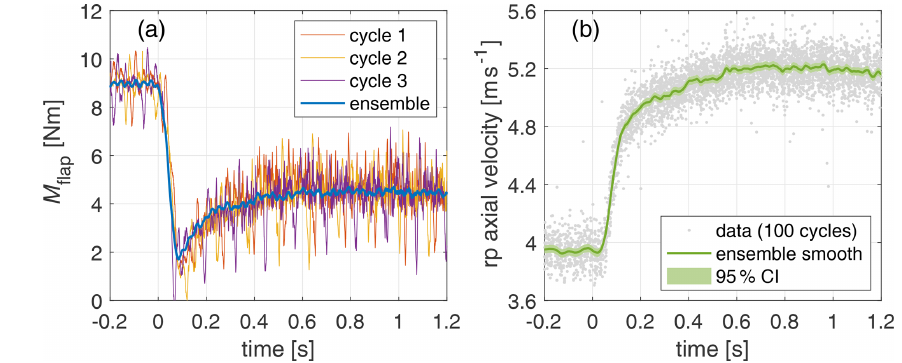
Figure 6. (a) Single cycles and ensemble average of flapwise blade root bending moment M flap . (b) Data points and smoothed ensemble average for axial rotor plane (rp) velocity in bisectrix of